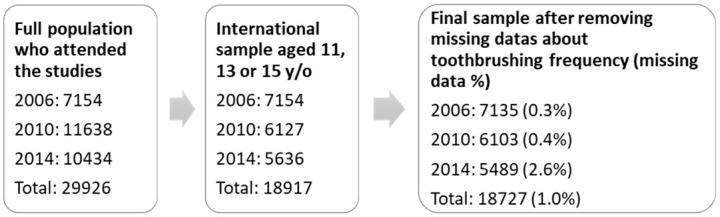
Flow chart.In 2006, the study was designed to comply with the international requirements while, in 2010 and 2014, the sample was larger to better describe a specific French population.